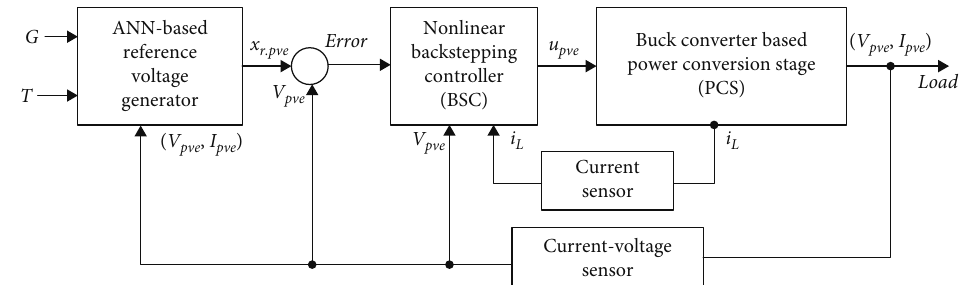
Figure 2: Closed loop controlled system of the proposed PVE.